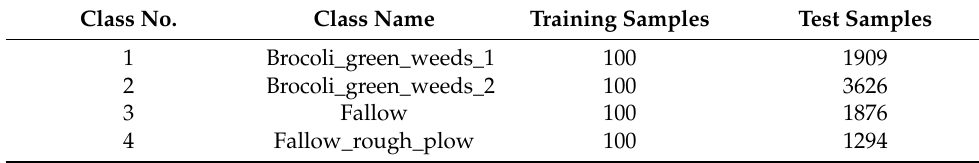
Table 4. The number of training and test samples used in the Salinas Valley dataset. Class